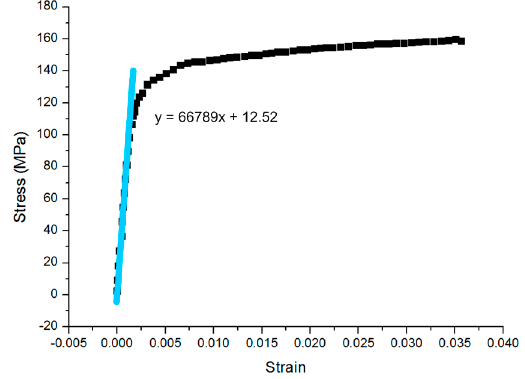
Table 3. Results of Young’s modulus (GPa) by tensile testing.